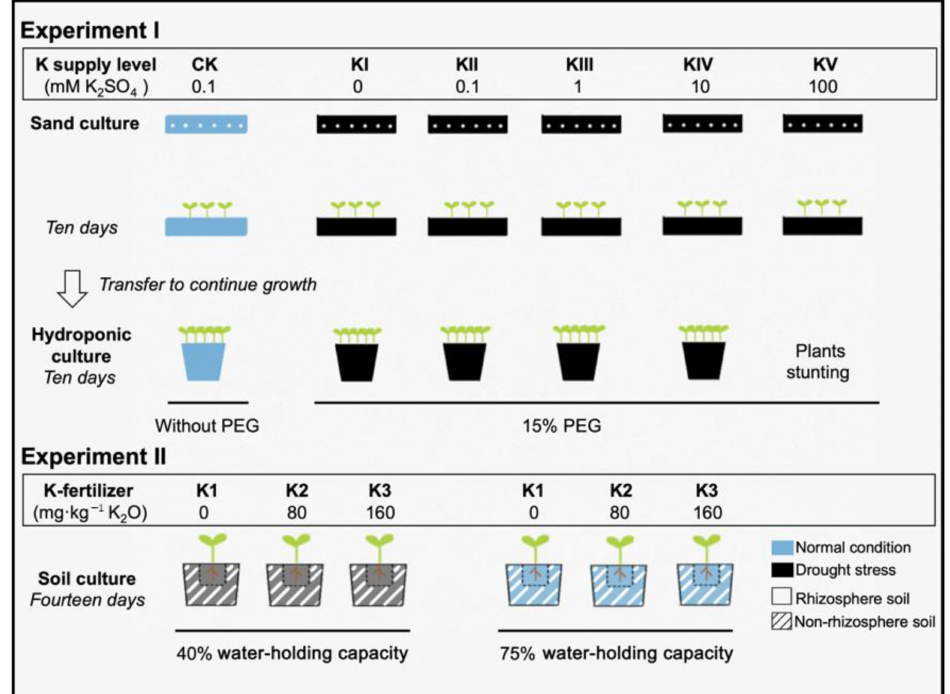
Figure 8. Schematic illustrating the design of Experiment I and II. Two rapeseed cultivars (CY36 and YY57) were cultured by those ways in both experiments. In the sand culture, 100 seeds were planted evenly in a germination box to establish root system architecture. In the hydroponic culture, 10-day-old rapeseed seedlings were transplanted to each pot to obtain root exudates. The treatment of Experiment I consisted of five replicated pots. In Experiment II, the dotted line record root bags that separate the rhizosphere and non-rhizosphere soil. The soil moisture treatments were started when the seedlings reached the six-leaf stage, each replicated four